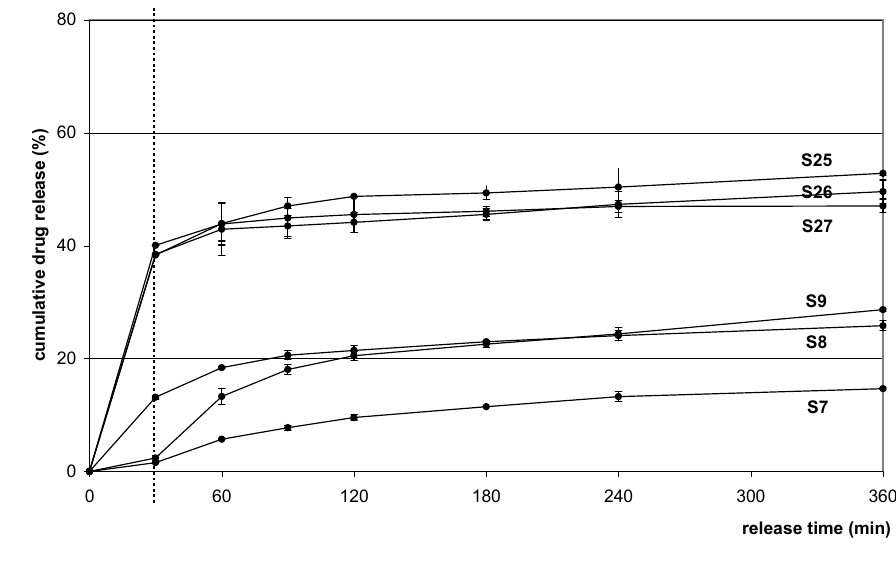
Figure 4. Effect of drug/copolymer ratio (factor X S7 ( − 1; +1; − 1), S8 ( − 1; +1; 0), S9 ( − 1; +1; +1), S25 (+1; +1; − 1), S26 (+1; +1; 0) and S27 (+1; +1;